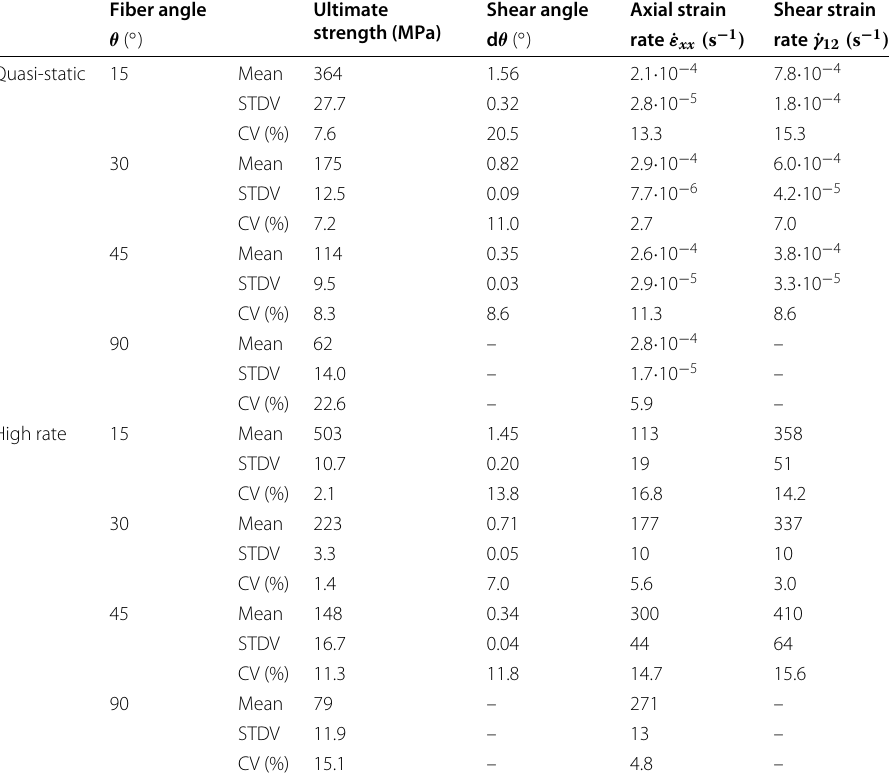
Table2 Quasi-static and high rate off-axis tension and transverse tension properties Fiber